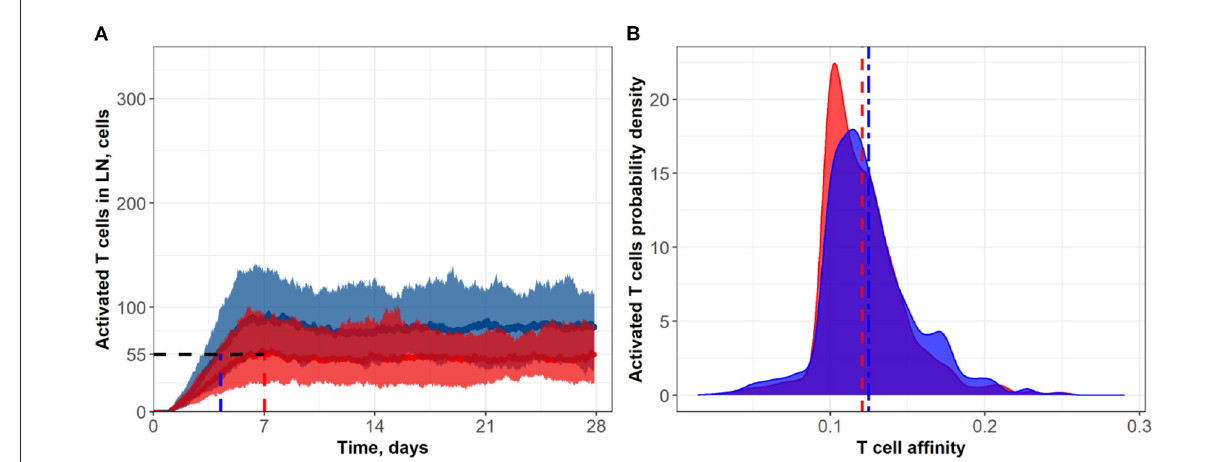
FIGURE5 (A) Population dynamics of activated T cells in the LN T zone during immune response initiation: Control conditions (red) and after administration of an anti CTLA-4 blocking antibody (blue). (B) Affinity distributions of activated T cells: Dotted vertical lines represent mean affinities for control and anti CTLA-4 conditions. Simulations were run under scenarios with different values for the activation signal amplitude: α = 3 (blue; anti CTLA-4 conditions) and α = 1 (red; control). Corresponding data files are available at the free repository GitHub at: https://github. com/Potamophylax/ABM_anti-CTLA-4/tree/main/Numerical%20Results/Hypothesis%20III.